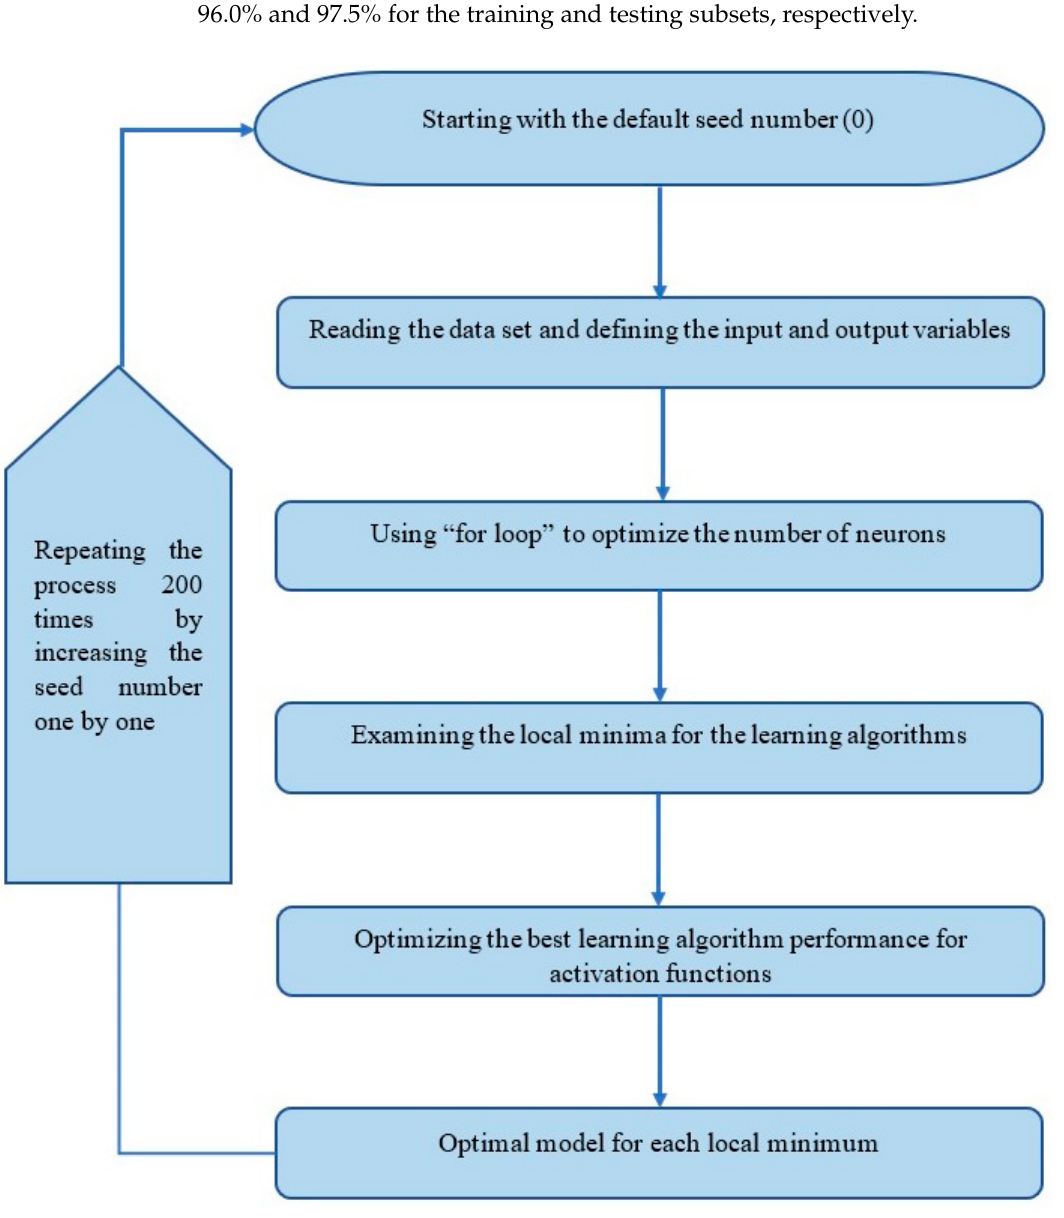
Figure 4. The development steps of the Matlab code optimisation process.